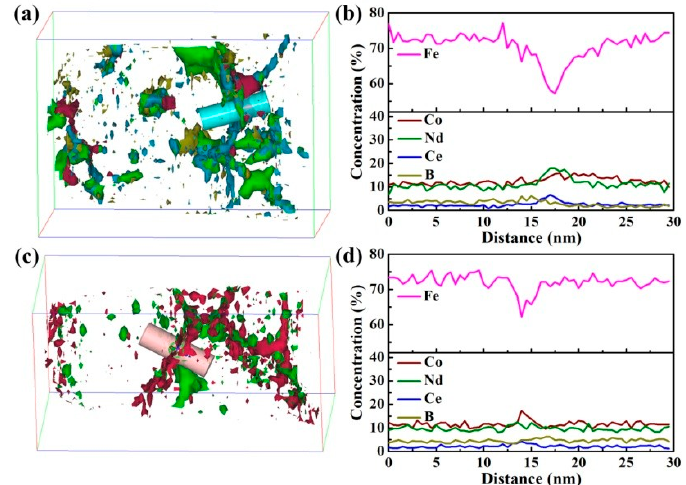
Figure 4. ( a ) Atom probe tomography (APT) result from the region close to the free surface of melt-spun (Nd 0.8 Ce 0.2 ) 2.4 Fe 12 Co 2 B ribbons: APT reconstruction illustrates segregation by isoconcentration surfaces of 15 at% Nd (green), 4 at% Ce (blue), 14 at% Co (red), and 6 at% B (yellow); ( b ) The concentration depth profiles obtained from the selected analyzed volume shown in ( a ); ( c ) APT result from the region close to the free surface of the (Nd 0.8 Ce 0.2 ) 2.4 Fe 12 Co 2 B sample annealed at 773 K for 15 min with 1 T magnetic field: APT reconstruction illustrates segregation by isoconcentration surfaces of 12 at% Nd (green) and 14 at% Co (red); ( d ) The concentration depth profiles obtained from the selected analyzed volume shown in (c) .